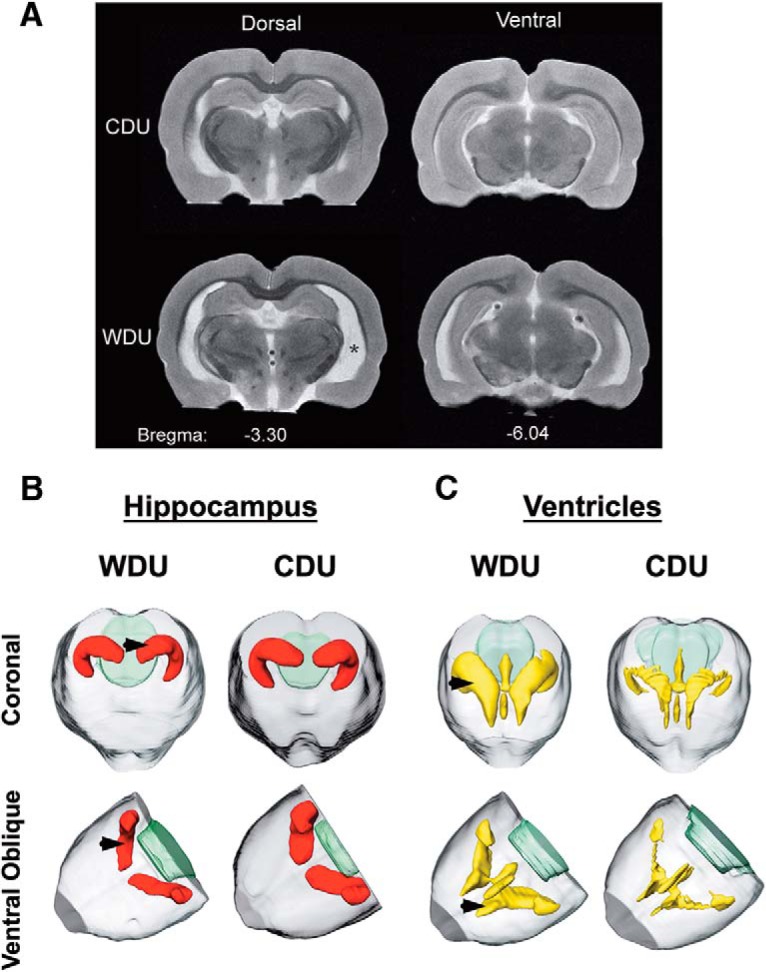
WD consumption led to hippocampal atrophy and ventricular enlargement. A, Representative MR images showing reductions in the anteroposterior hippocampal volume in the rats that consumed the WD. The asterisk indicates larger lateral ventricles in the rats that consumed the WD. B, C, 3D coronal and ventral oblique MRI reconstructions show the impact of the WD on the hippocampal (B; red, arrowheads) and ventricular (C; yellow, arrowheads) volumes.